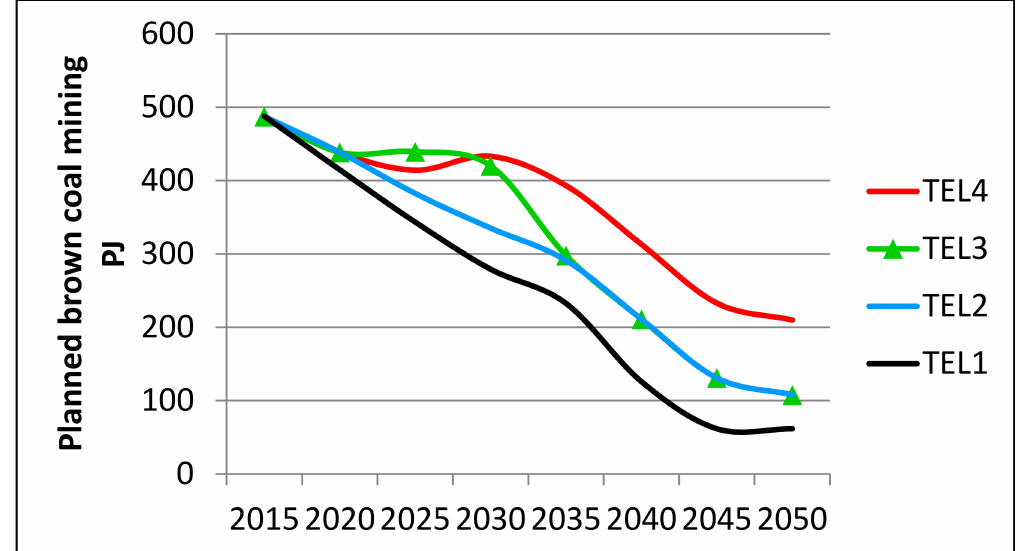
Figure 1. Planned brown coal mining in the four Territorial Environmental Limits variants (5-year averages). Source: own compilation based on